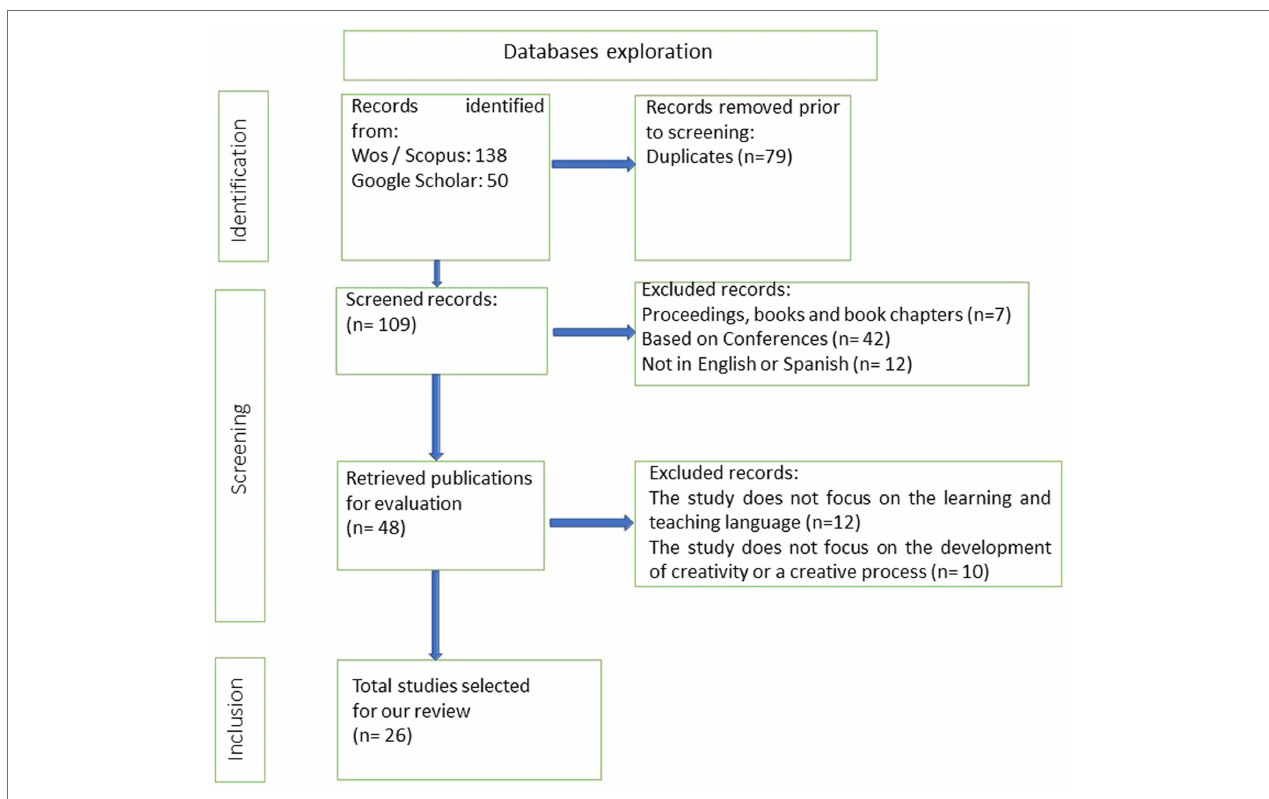
FIGURE 1 | Screening procedure of the